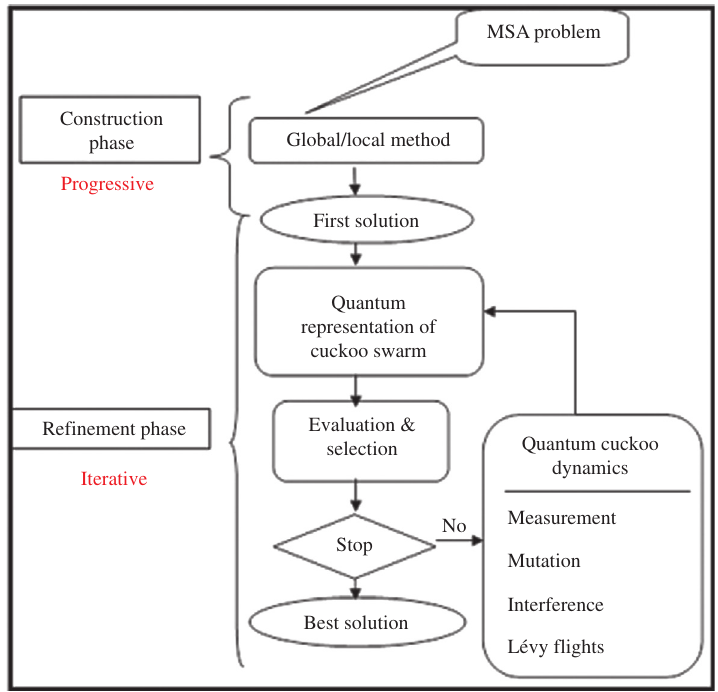
Figure 2. Flowchart of the Proposed